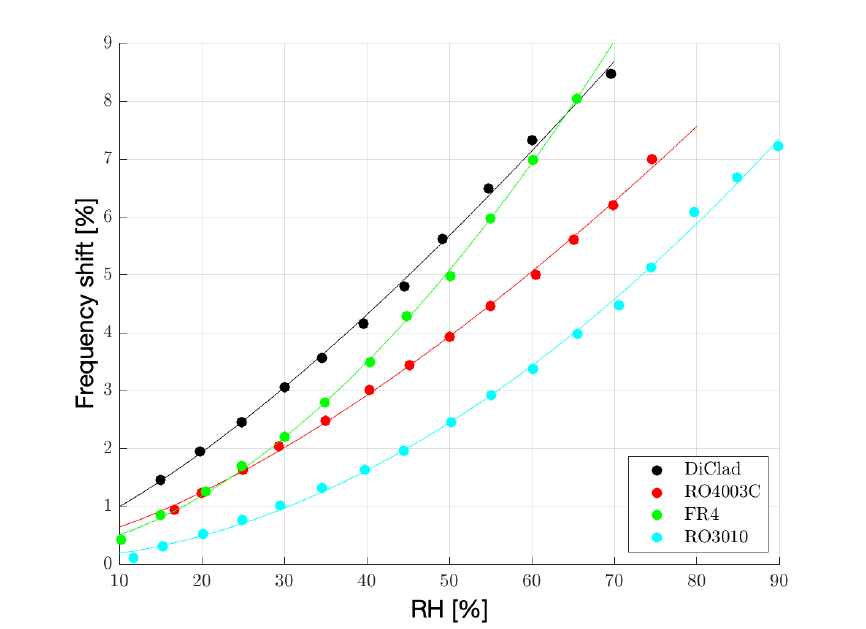
Figure 8. Sensor sensitivity, calculated as a percentage of the frequency shift of the normalized resonance peak, monitored for RH measurements up to